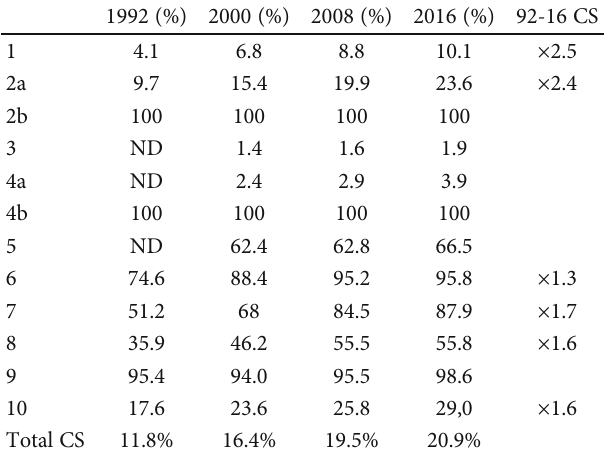
Robson groups 1 and